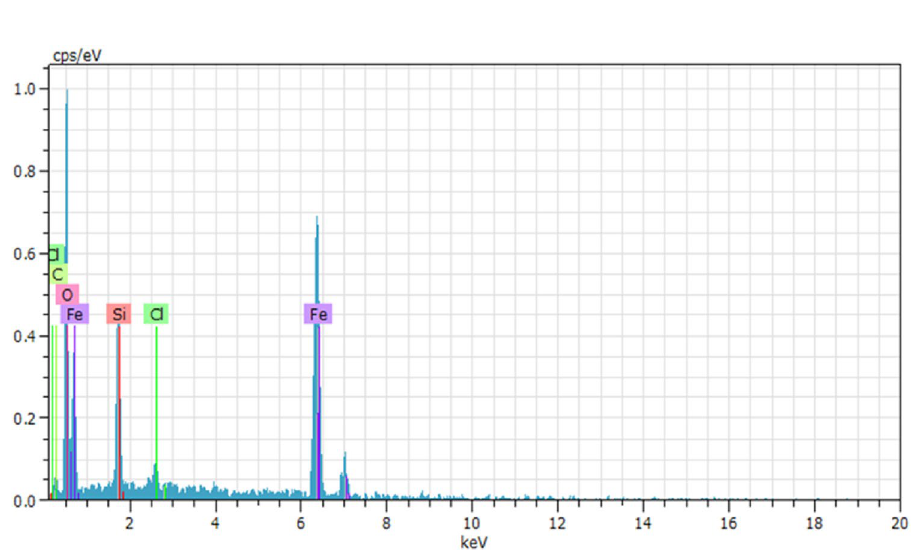
Figure 4. EDX Spectrum of Fe 3 O 4 @SiO 2